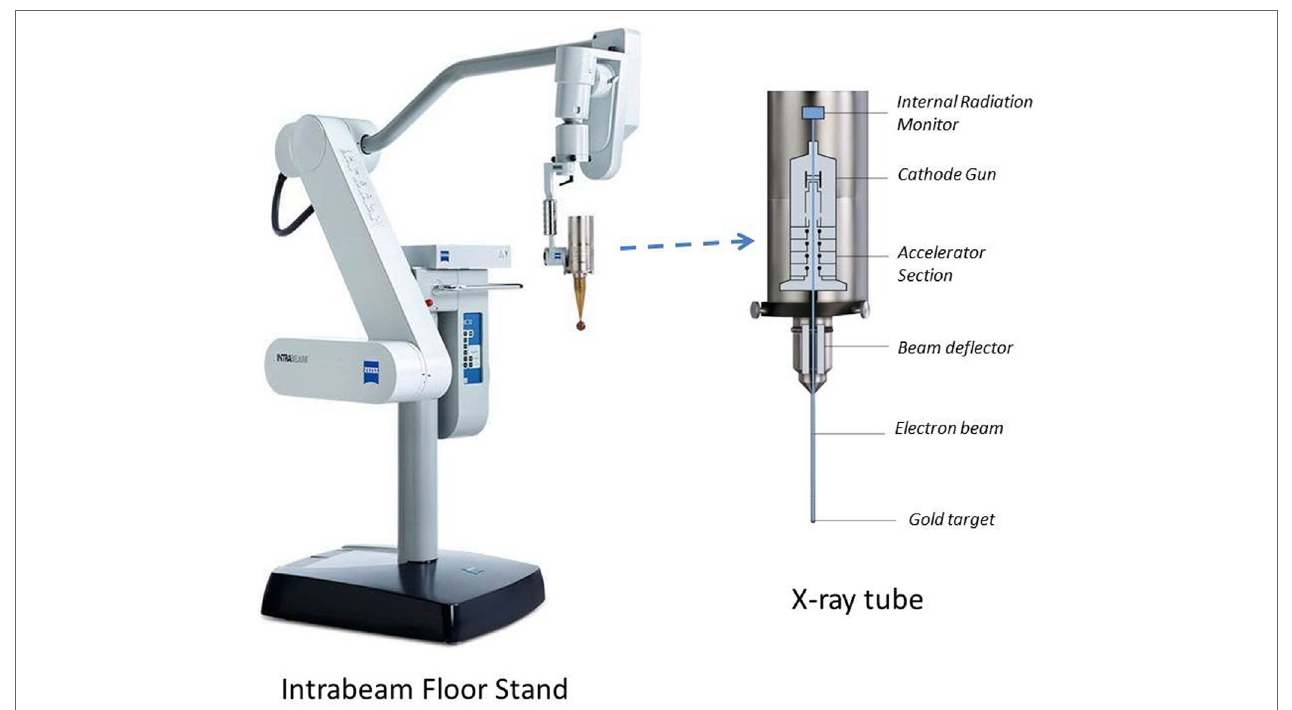
FigUre 1 | Intrabeam stand and X-ray source shown with spherical applicator attachment. The floor stand provides full flexibility of movement for the X-ray tube with millimeter precision in six dimensions. The floor stand weighs 275 kg and has dimensions of 74 cm × 194 cm × 150 cm (W × H × L) in transport position. Also shown are internal components of the X-ray source (dimensions: 7 cm × 11 cm × 17 cm; weight: 1.6 kg).